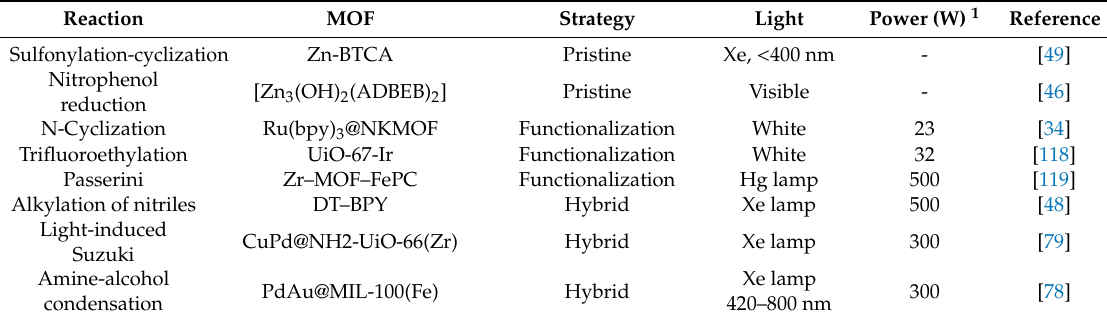
Table 16. Other photocatalytic organic transformations mediated by